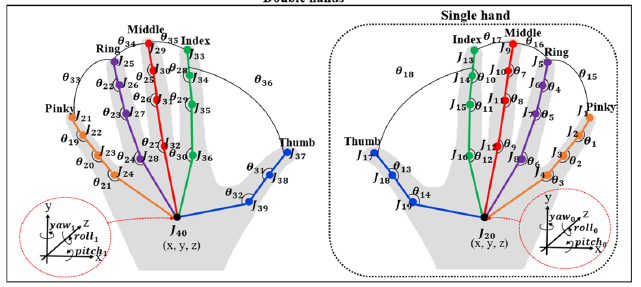
Figure 9. Spatial–temporal finger joint angle patterns.